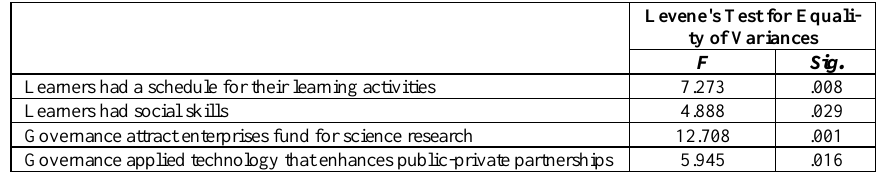
Table 6. Levene test between non-IT staff and IT staff